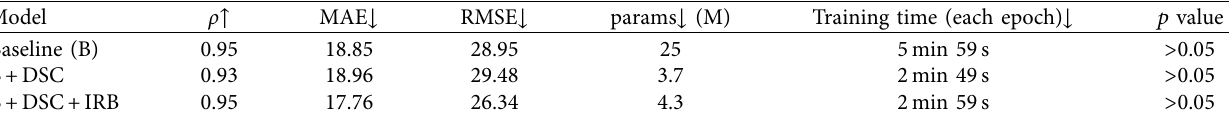
Table 3: Ablation analysis for the proposed architecture. ↑ denotes larger is better, and ↓ denotes smaller is better. The best results with different backbones are highlighted in red.